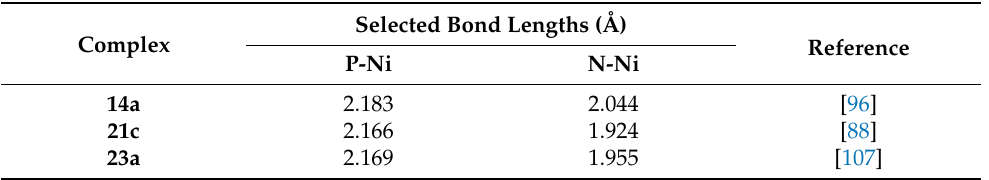
Table 2. Selected bond lengths (Å) of unsymmetrical nickel PCN pincer complexes,